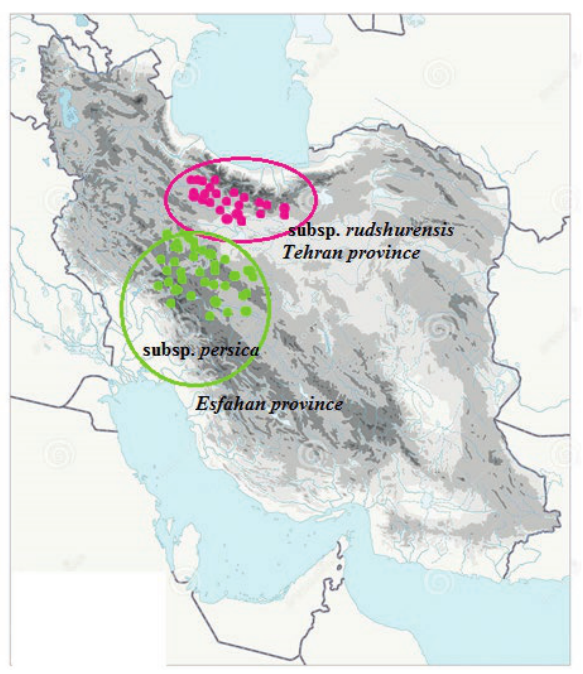
Figure 1. Distribution map of studied populations of Salicornia per- sica in